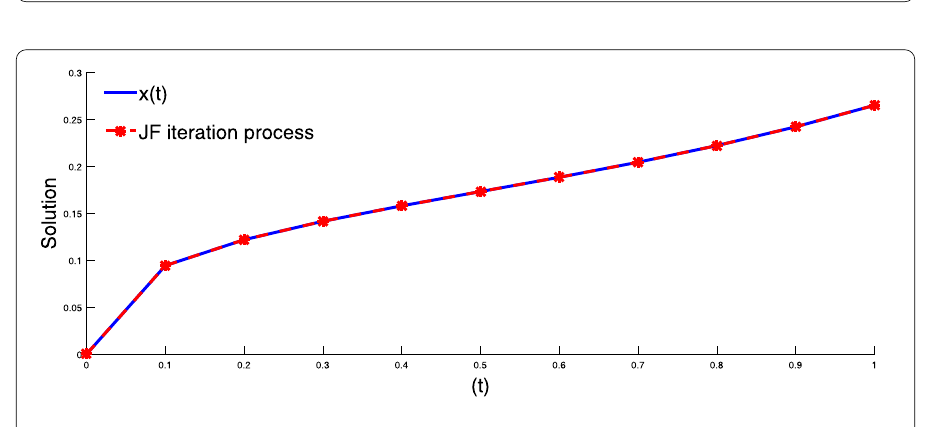
Figure 5 Graphical representation of exact solution and approximated solution of problem (6.3) by using the JF iteration process at k = 31